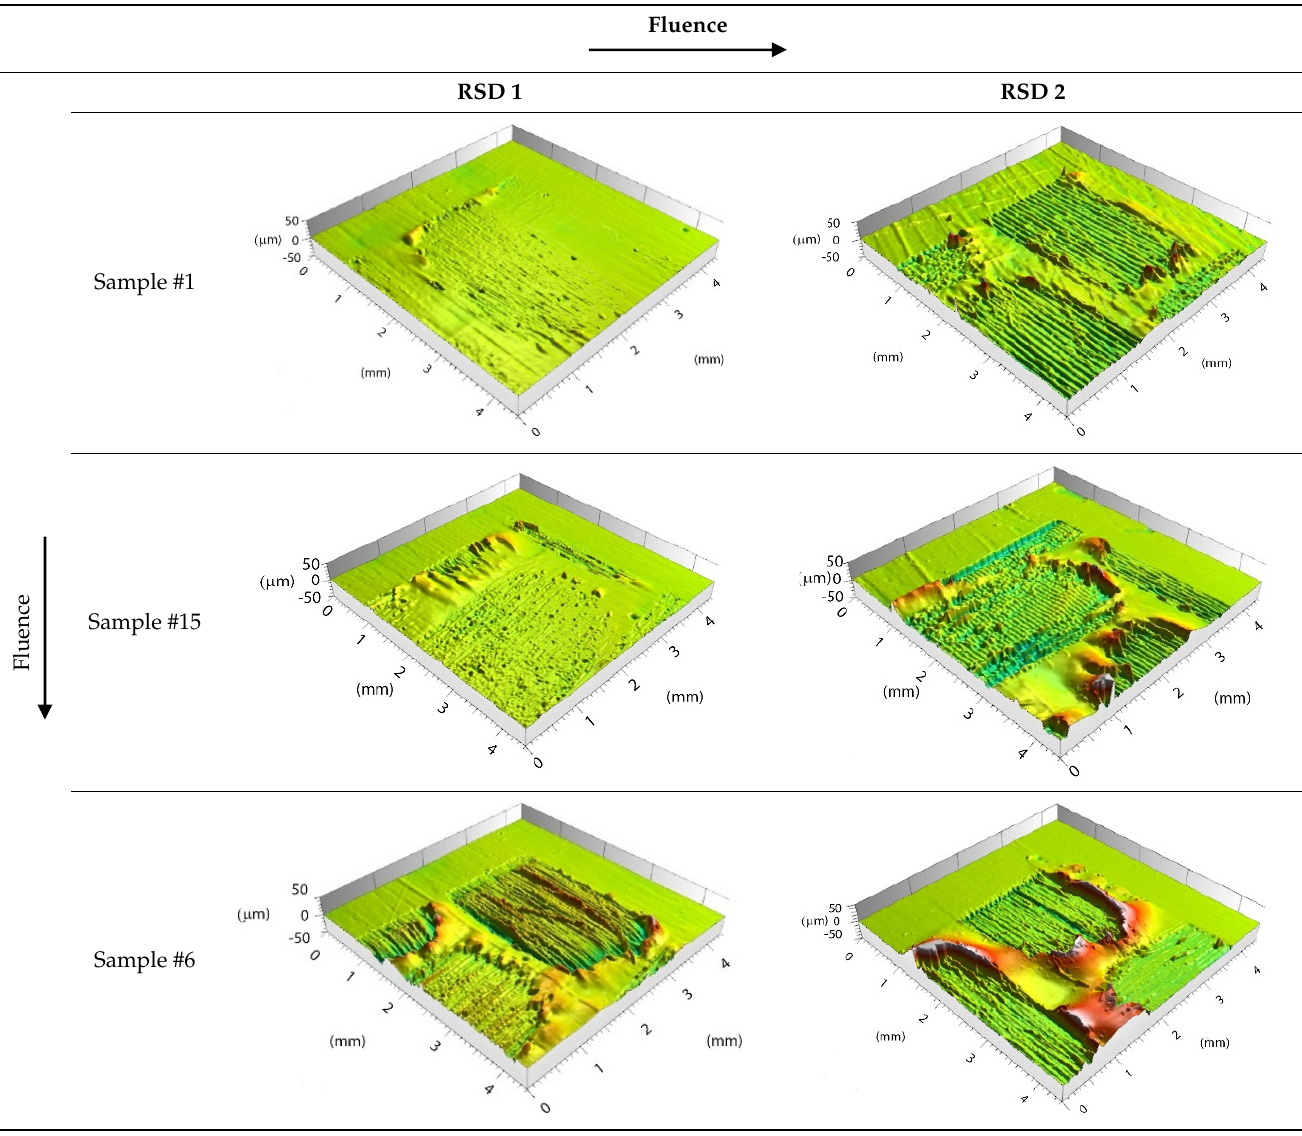
Table 6. Morphology of six macro groups sorted according to fluence value.